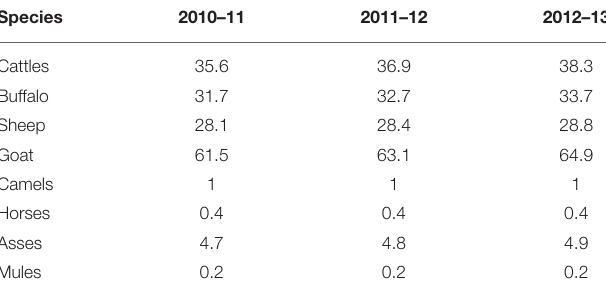
TABLE 6 | Livestock population (in millions) in Pakistan from 2010 to 2013 (Uddin et al., 2016).